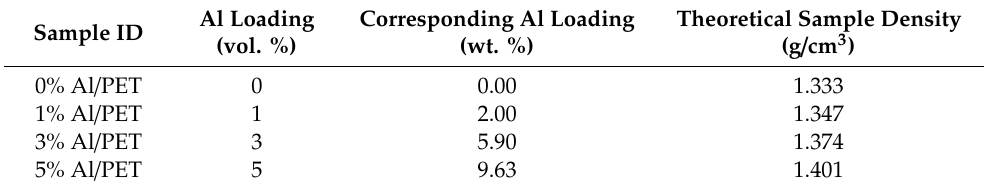
Table 3. AluminumloadingpercentagesandtheoreticaldensitiesofNanoAl2 /